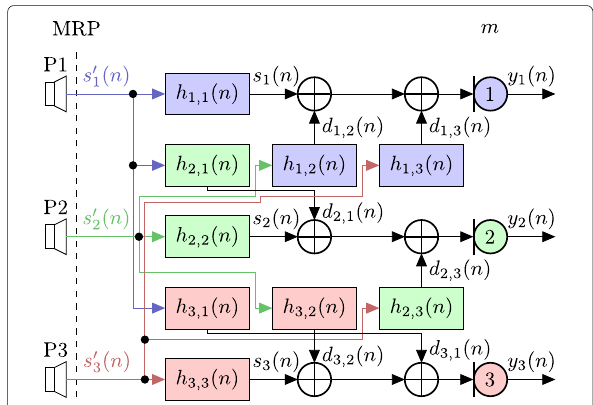
Fig. 2 The acoustic channel model of the considered meeting scenario.Eachspeaker’svoicecouplesintotheclose-talkmicrophones of all other participants. Thereby, the source signal s (cid:4) m ( n ) , m ∈ M , is filtered by different room impulse responses h m , μ ( n ) with m , μ ∈